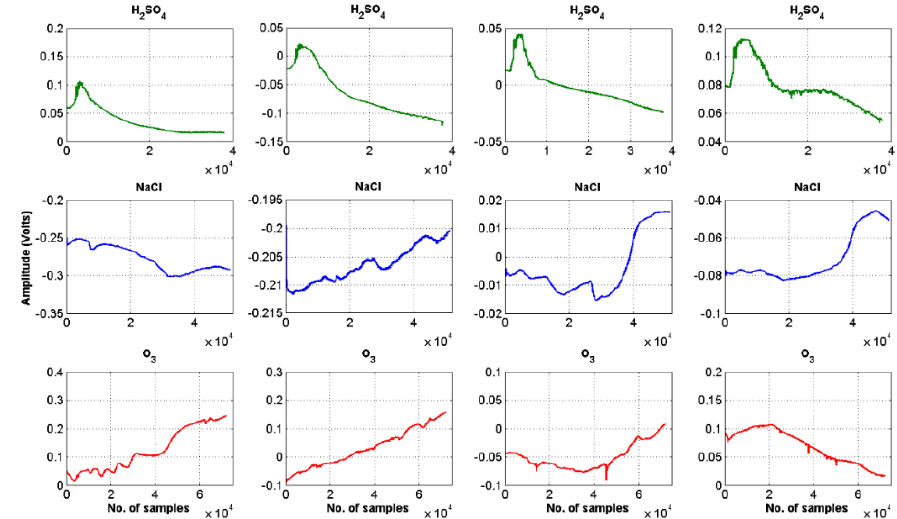
Figure 4. Raw plant electrical signal response after application of three types of stimuli.